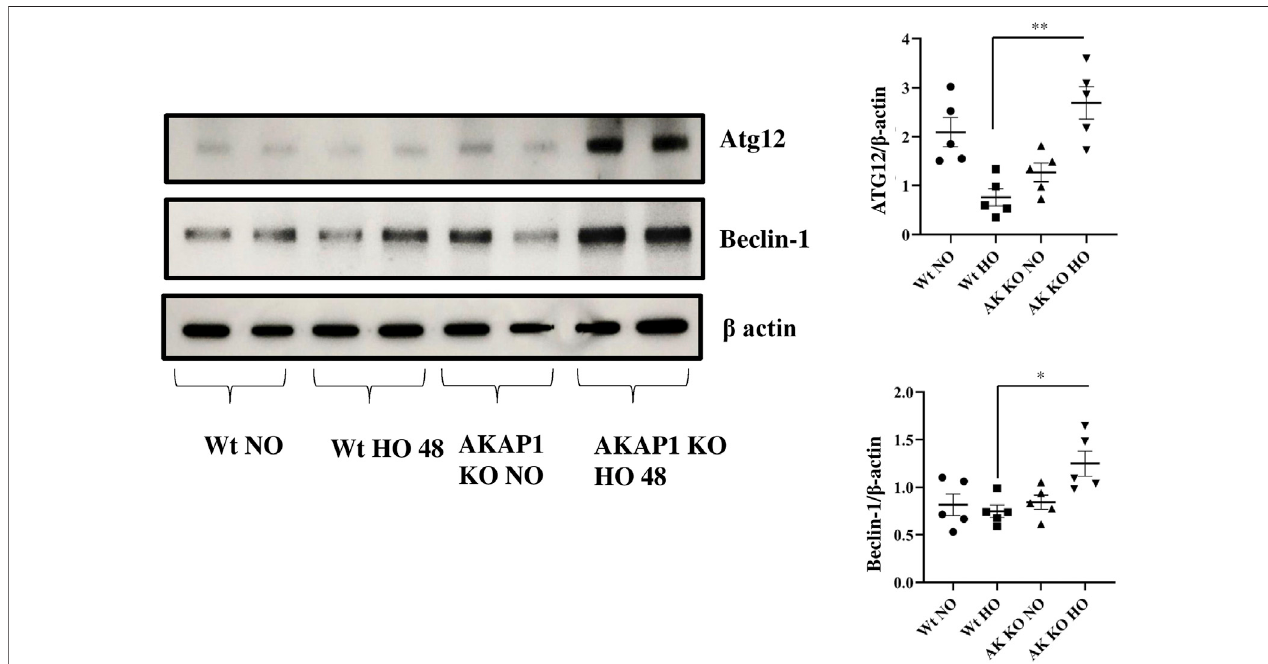
FIGURE 6 | Akap1 genetic deletion enhances autophagy after hyperoxic exposure: Wt and Akap1 mice were exposed to normoxia and hyperoxia for 48 h. After hyperoxia,themice werekilled, andprotein wasextracted from thelungsand subjectedtoWesternblotanalysistoevaluatetheproteinexpression of Atg12